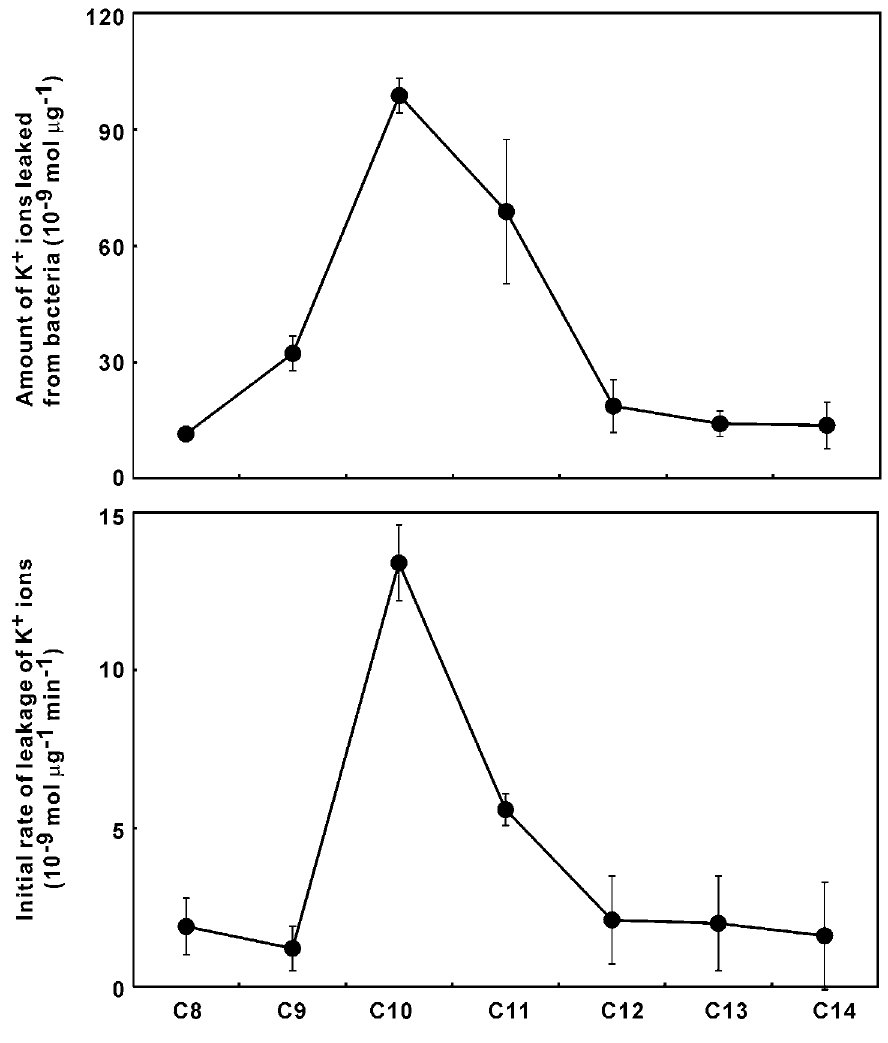
Figure 5. K + ion leakage from S. aureus FDA209P in response to 1-alkanols. The final concentration of each 1-alkanol was 80 µ g mL -1